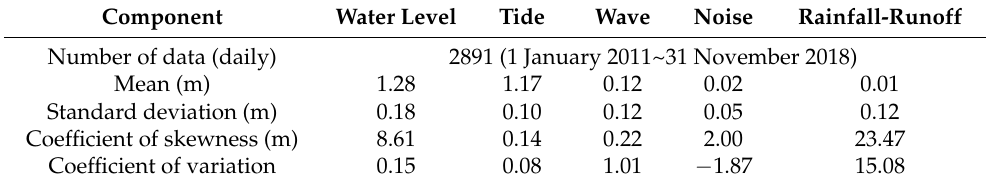
Table 2. Rate of influence for each component.